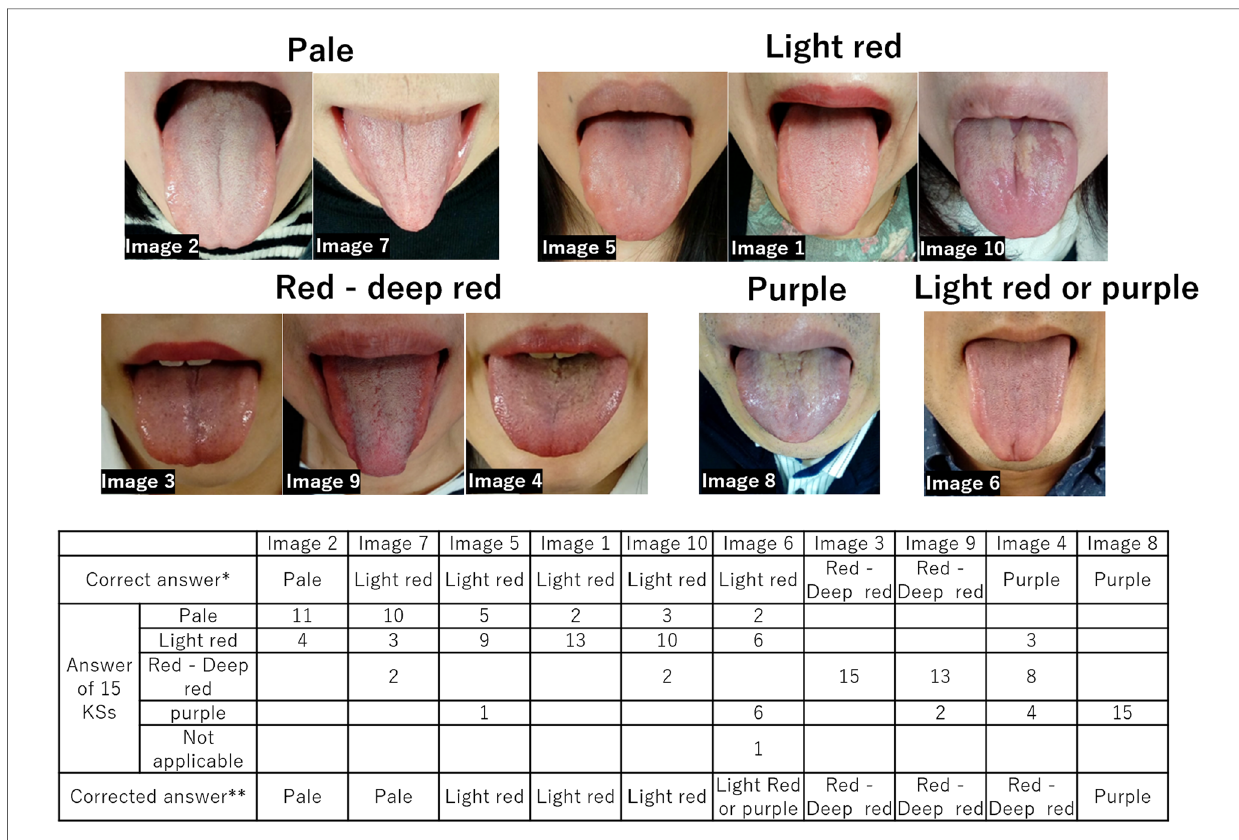
FIGURE 7 Grouping of tongue color based on a majority vote (Study 1). The correct answers for Q50(Image7), Q42(Image6), and Q26(Image4) were corrected when the decision was made again by a majority vote of 15 KSs. The tongue images classi fi ed based on the majority vote are shown above. *Correct answer is based on the information in the tongue image database, which was automatically determined by a majority vote of the diagnostic results of fi ve Kampo specialists (KS-D participants). **Corrected answer is redetermined by a majority vote of the diagnostic results of 15 KSs. KSs, Kampo specialists; KS-D, KS of the database developer